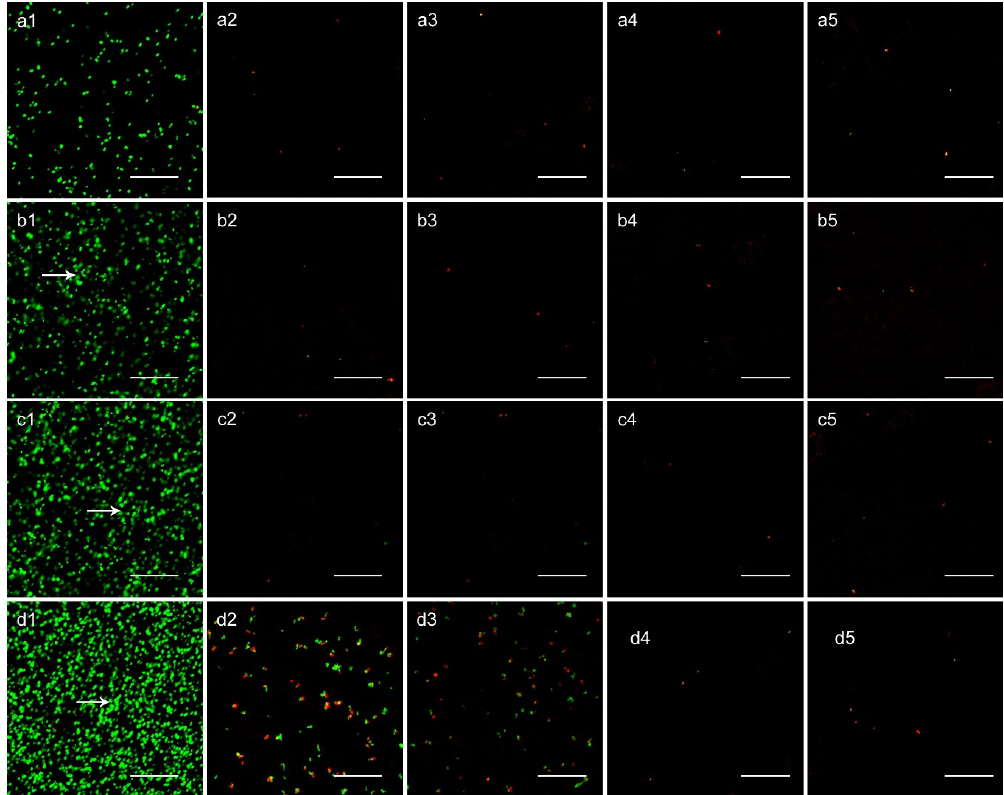
Figure 6. CLSM analysis of bacterial viability on different surfaces. (1) Smooth Ti; (2) NT-H80; (3) NT-H120; (4) NT-H160; (5) NT-H200 incubated with ATCC 43300 for ( a ) 6 h; ( b ) 24 h; ( c ) 48 h; and ( d ) 72 h. Arrow head indicates the bacteria colony in biofilm. The magnification level is ×400. The scale bar is 50 μ m.